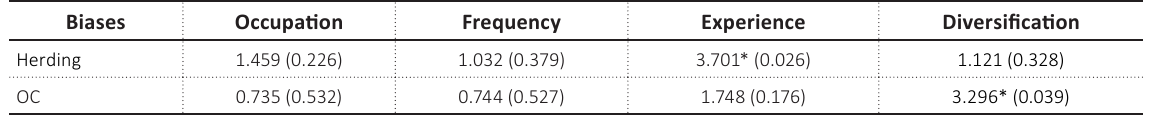
Source: Authors’ calculations.